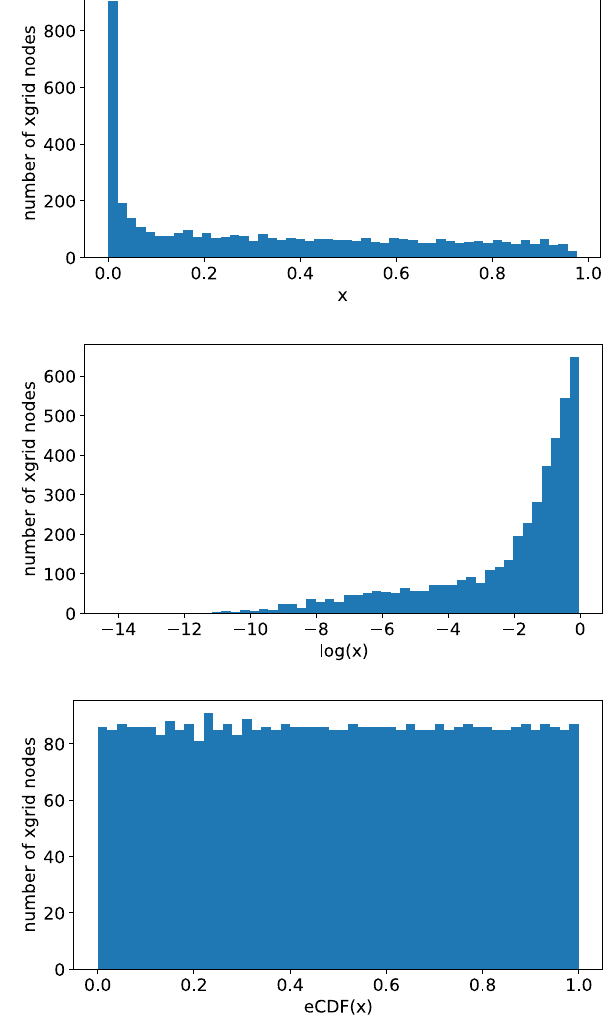
Fig. 3 Histograms showing the distribution of the unscaled x points in the FK-table x -grids (top), as well as the distribution of the input points after scaling with log x (middle) and eCDF